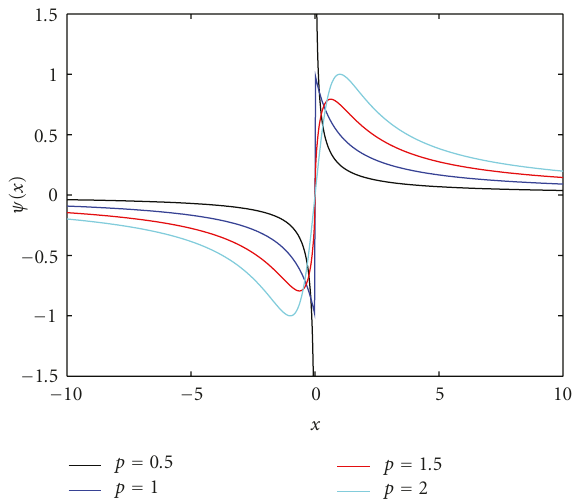
Figure 2: Influence functions of the M-GC estimator for di ff erent values of P . (Black:) P = . 5, (blue:) P = 1, (red:) P = 1 . 5, and (cyan:) P =